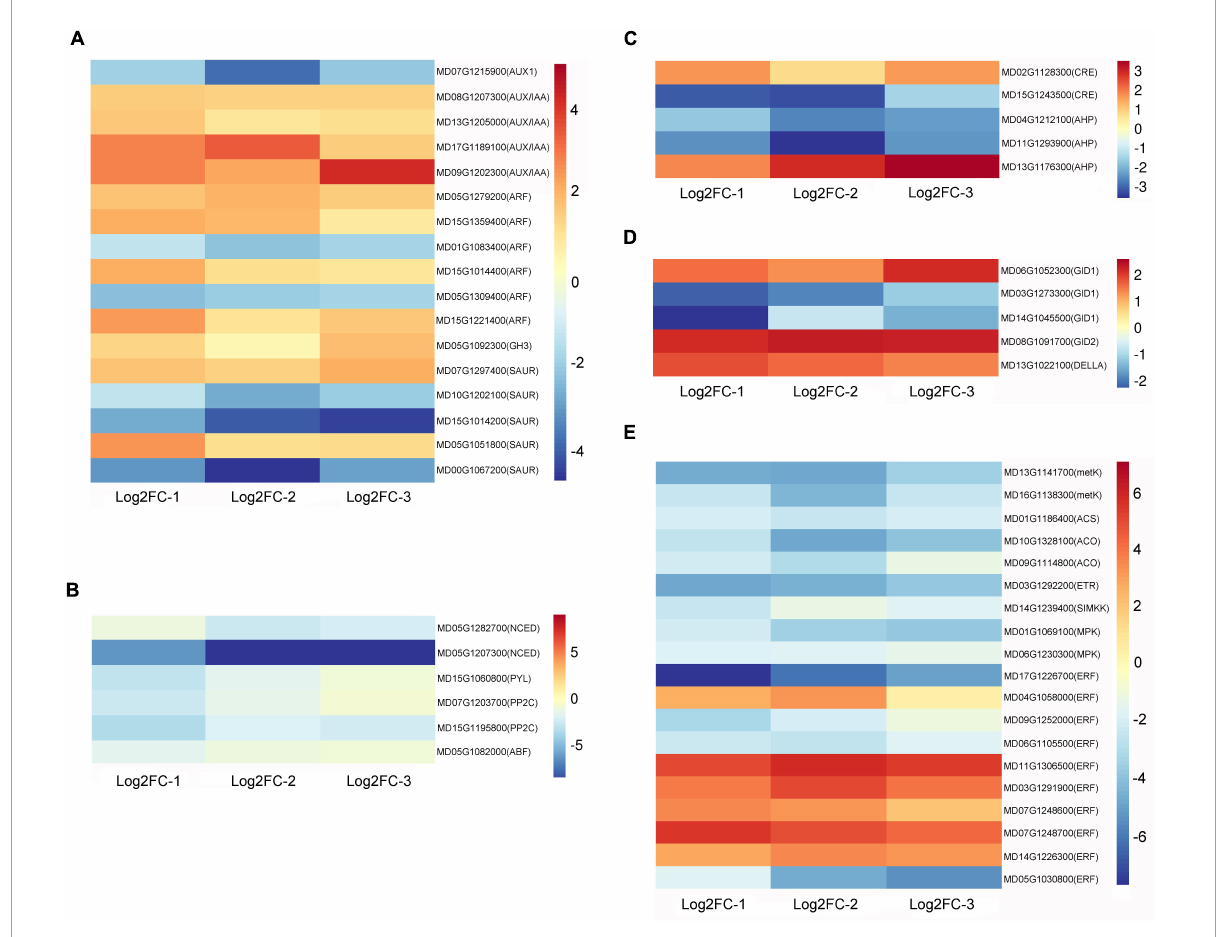
FIGURE2 Heat maps of plant hormone-related DEGs after waxing treatment in apple fruit. Selected DEGs related to auxin (A) , abscisic acid (B) , cytokinin (C) , gibberellin (D) , and ethylene (E) from RNA-Seq date. Log2FC-1, Log2 (Fold Change) value of Waxed-1 and Control-1 in apple fruit RNA-Seq; Log2FC-2, Log2 (Fold Change) value of Waxed-2 and Control-2 in apple fruit RNA-Seq; Log2FC-3, Log2 (Fold Change) value of Waxed-3 and Control-3 in apple fruit RNA-Seq. The scale bar indicates upregulated (red) and downregulated (blue)